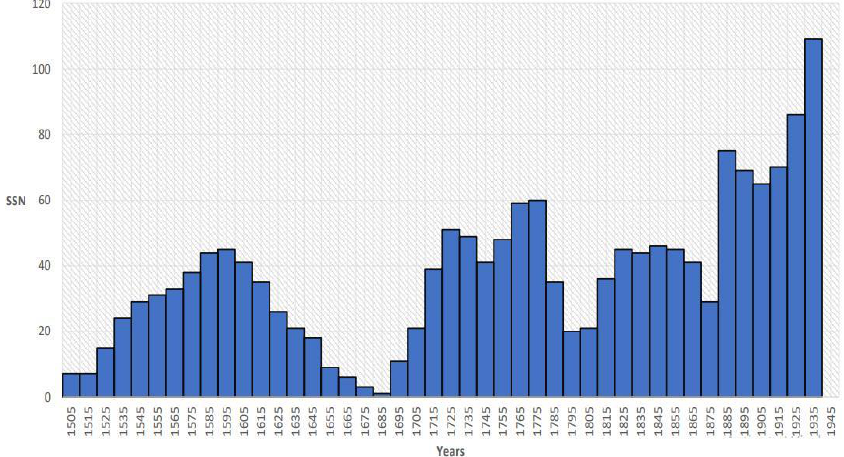
Figure 3. Solar activity in the years of 1500 to 1950, given in decadal sunspot numbers (SNN). The time period of 1500 to 1890 is based on the reconstruction by Wu et al. [63], while actual sunspot numbers (directly observed or photographed) were used for the later decades (SILSO data, Royal Observatory of Belgium, Brussels).